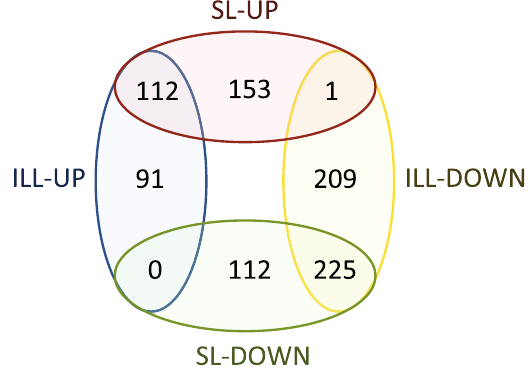
Figure 3. Differentially expressed genes obtained with SL-seq (SL-UP and SL-DOWN) and Illumina stranded mRNA seq methods (ILL-UP and ILL-DOWN). Genes were considered significantly upregulated if the FDR adjusted p- value was lower than 0.05 and the log2FC greater than 1. Genes were considered significantly downregulated if the FDR adjusted p- value was lower than 0.05 and the log2FC bigger smaller than − 1.